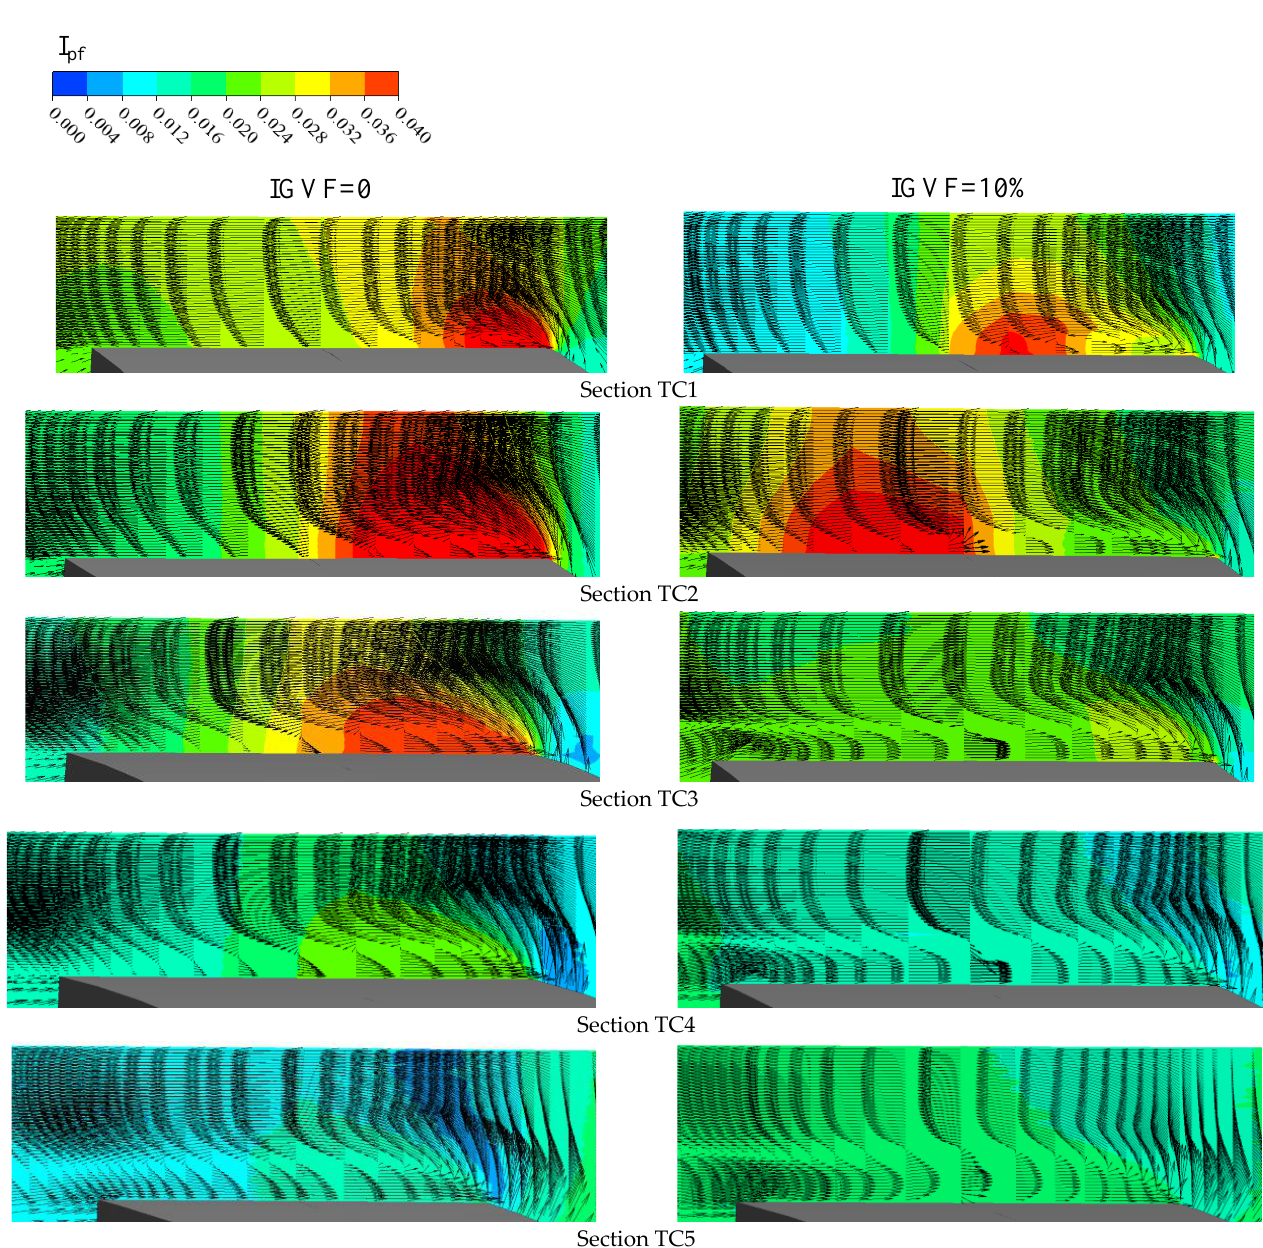
Figure 16. Sections near the impeller blade tip.